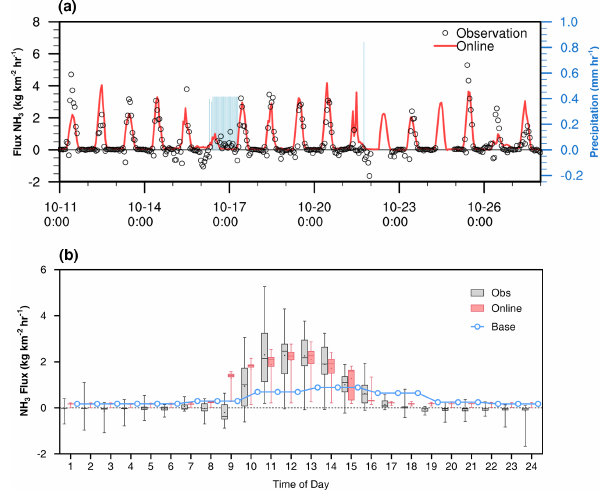
Figure 4. (a) Time series of observed (black symbol) and WRF– Chem online model NH 3 flux (red line) above the agricultural field in Hengshui, China from the 11 to 27 October 2012. (b) Diel hourly box plots of observations flux measurements (gray), paired with on- line model results (pink) and base model results (blue). The 5th and 95th percentiles are represented by the whiskers, the 25th and 75th quantiles are enclosed in the box, the median is represented by the horizontal line through the box, and the mean value is the dot in the box. Diurnal profile of emissions from agriculture is applied in the base experiment following Du et al.